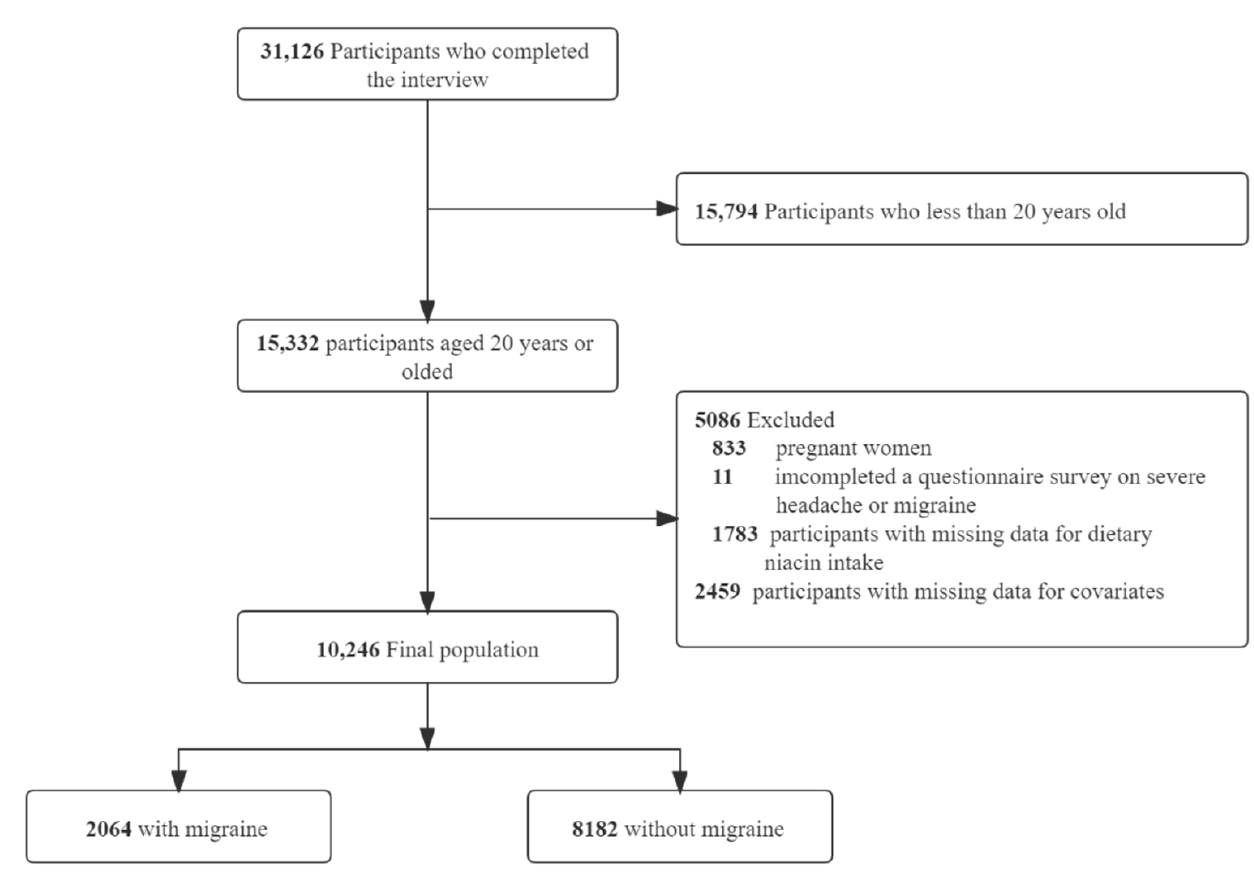
Figure 1. The study’s flow diagram.